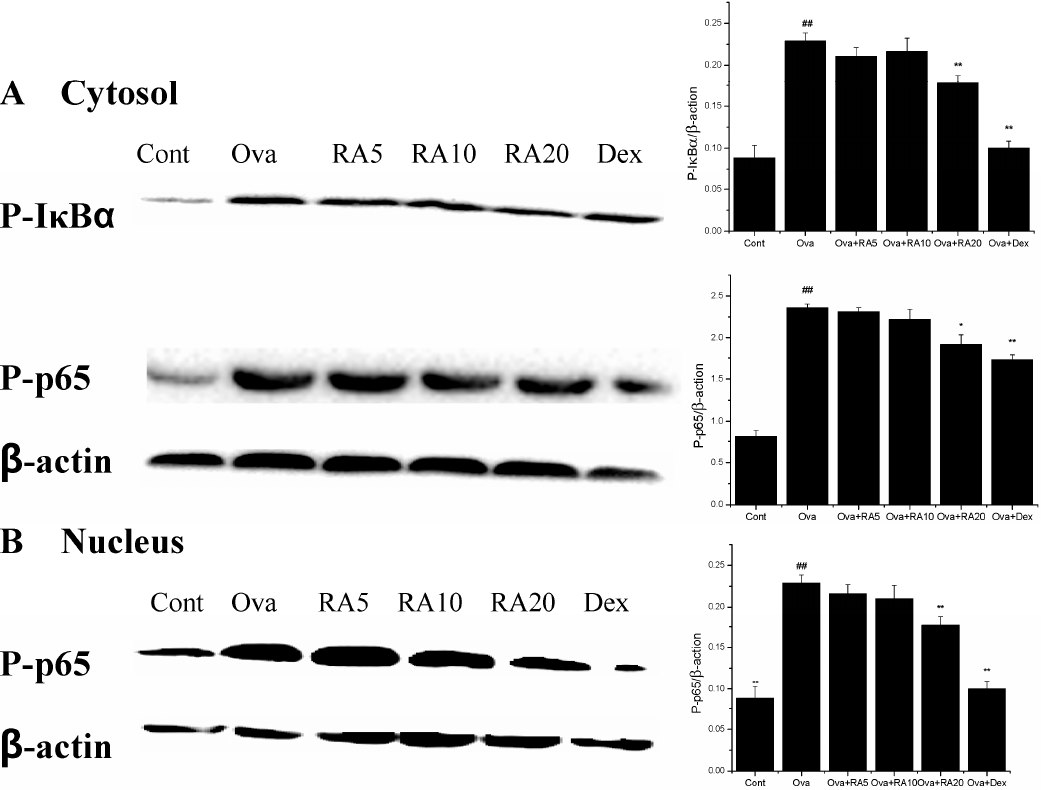
Figure 6. Effects of RA on Ova-induced I κ B α phosphorylation and NF- κ B activation in the lungs. ( A ) Detection of phosphorylated I κ B and p65 in the cytosol of lungs; ( B ) detection of phosphorylated p65 in the nucleus of lungs. I κ B α and NF- κ B phosphorylation were measured by Western blotting. The values represent the mean ± SEM of three independent experiments. # p < 0.05, ## p < 0.01 vs. control group; and * p < 0.05, ** p < 0.01 vs. Ova.